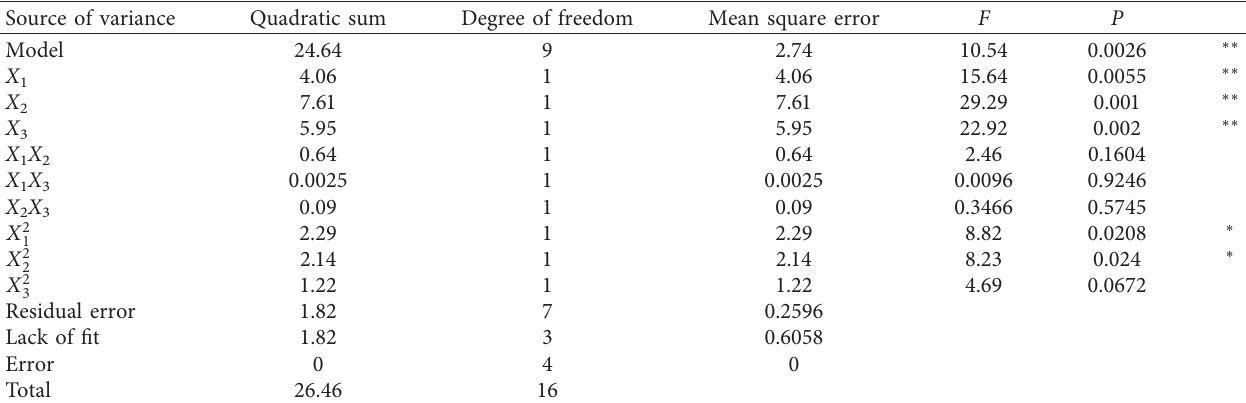
Table 4: Variance analysis of multiples